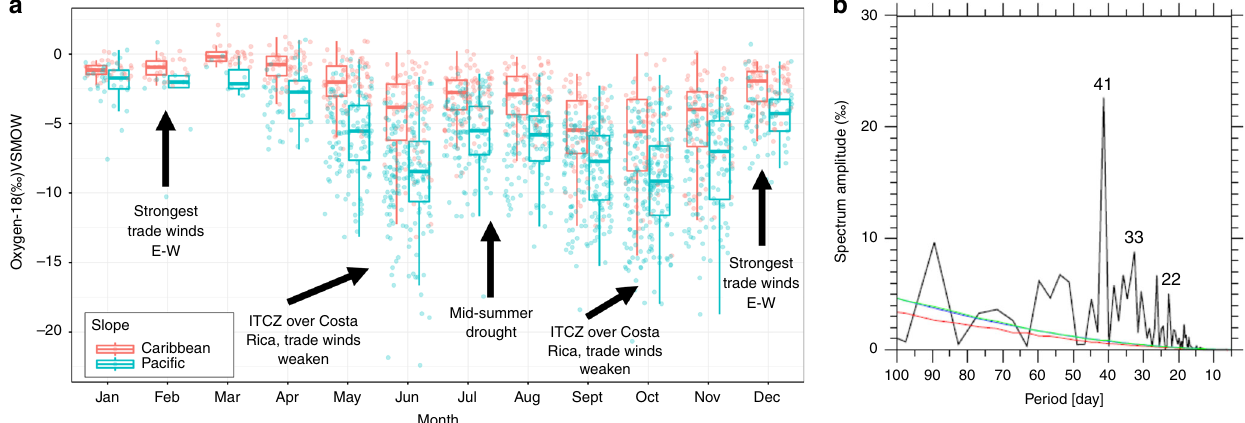
Fig. 3 Stable isotope variability ( δ 18 O, ‰ ) between 2013 and 2017 from the stable isotope monitoring network in Costa Rica. a Caribbean and Paci fi c slopes are denoted by red and cyan colors, respectively. Black arrows represent three main climatic features: east-west trade winds, displacement of the ITCZ (Intertropical Convergence Zone), and the MSD (Mid-summer drought). b Power spectrum of δ 18 O (spectrum amplitude, ‰ ) with Red Noise spectrum and 90% con fi dence interval (red and green lines, respectively) generated using REDFIT. The numbers denote the most signi fi cant frequency patterns